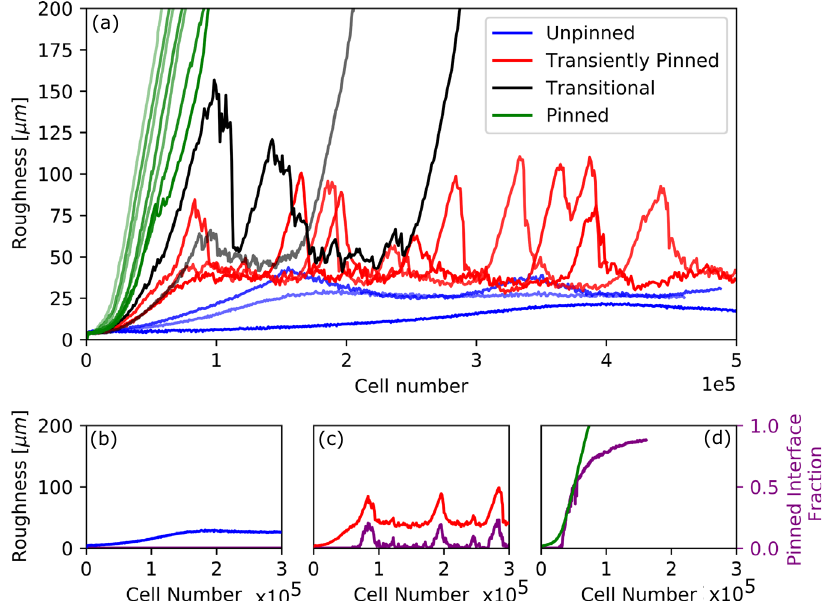
Fig. 5 Bio fi lm roughness dynamics driven by interface pinning. Panel a shows roughness trajectories (roughness vs cell number) for each of the simulations of Fig. 2, i.e. for varying S bulk and μ max . Trajectories in blue, red and green correspond to simulations in the unpinned, transiently pinned and pinned phases, respectively, as de fi ned by their interface pinning behaviour (see Fig. 4). The trajectories shown in black and grey appear to be transitioning between phases. Panels b – d show a sample roughness trajectory for each of the phases (blue/red/green line) plotted together with the corresponding trajectory for a fraction of the interface that is pinned, i.e. that has not moved in the previous 6 hours of simulated time (purple line). Panels b – d show the same simulations for each phase as Fig. 4, i.e. S bulk = 0.01 g/L, μ max = 0.1 1/h for the unpinned phase, S bulk = 0.01 g/L, μ max = 0.4 1/h for the transiently pinned phase and S bulk = 0.0005 g/L, μ max = 0.4 1/h for the pinned phase. Note that for the unpinned phase ( b ) the blue and purple curves are indistinguishable. Supplementary Figs. 7 and 8 show the same trajectories of interface roughness and pinned interface fraction for all of our simulations